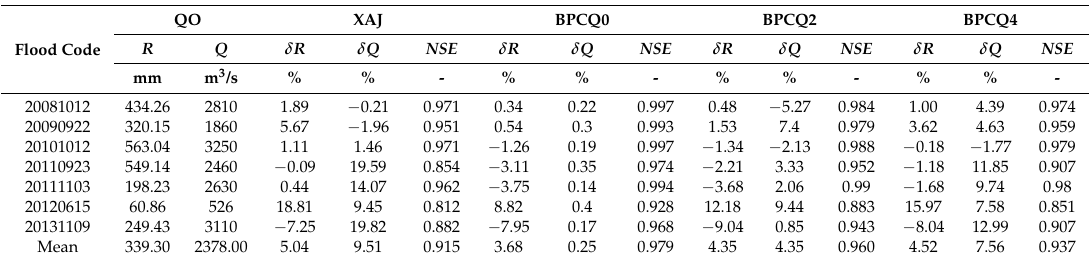
Table 4. Single period correction performance for verification